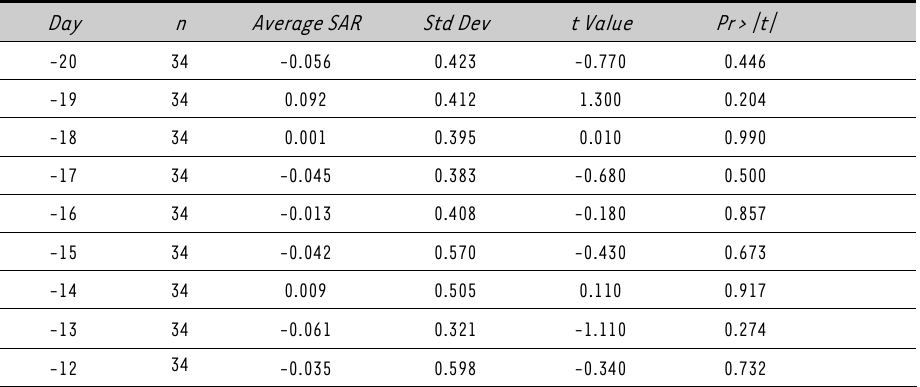
Daily Average Standardise Abnormal Return for the event period